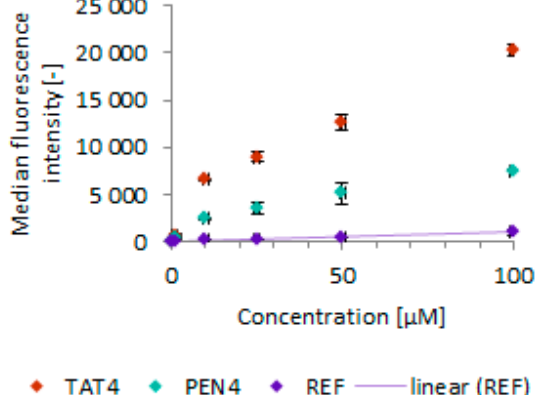
Figure 2. Comparison of median fluorescent intensity values of TAT4 (orange dots), PEN4 (green dots), and REF (purple dots) polymer conjugates in a wide range of concentration measured after incubation with HeLa cells at 37 ◦ C for 1 h by flow cytometry. Concentration of used REF is calculated with dye content of the polymer–peptide conjugates. Unspecific binding to cells increases linearly with the concentration with the coe ffi cient of determination R 2 = 99%. Direct penetration of CPP-bearing conjugates grows with increasing concentration in slower than linear manner.